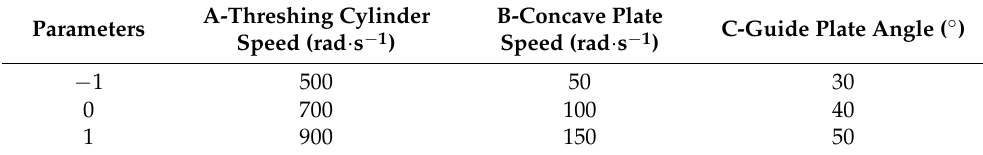
Table 5. Scheme of field